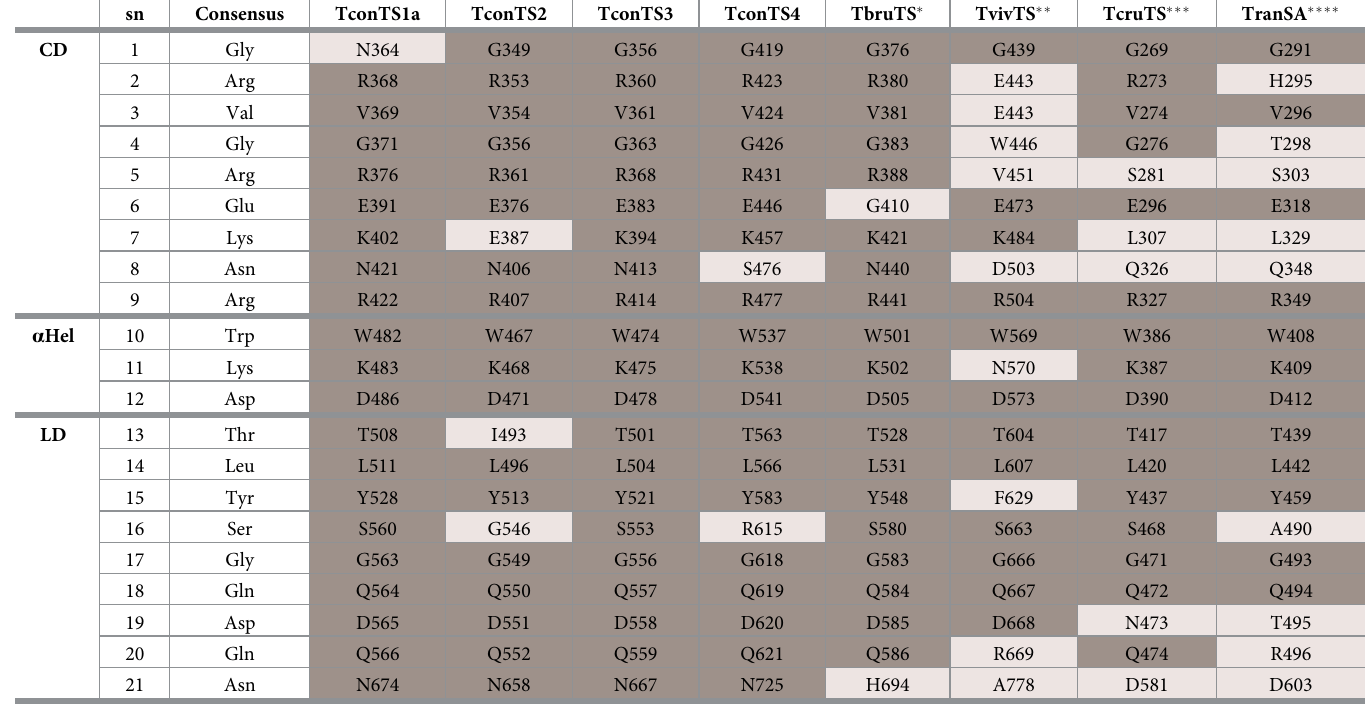
Table 3. Conserved amino acid residues involved in hydrogen bond formation between CD and LD at the contact site of